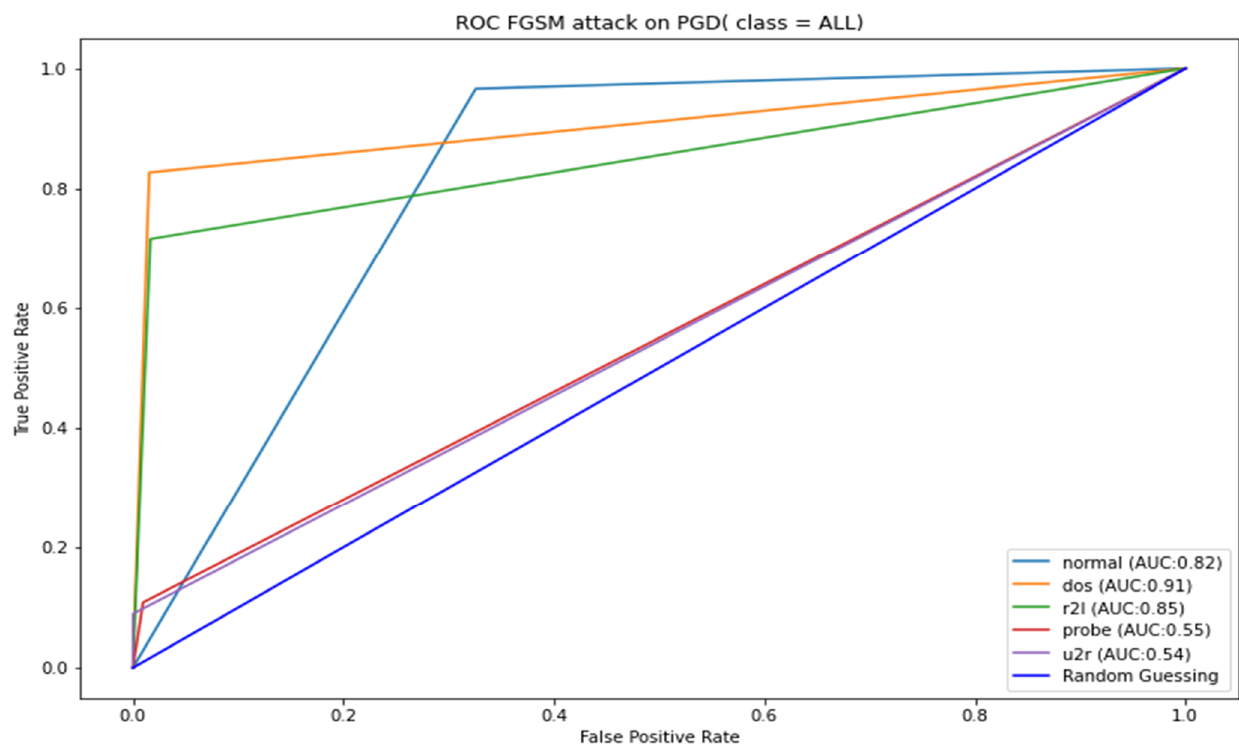
Figure A5. PGD robustness test against FGSM attacks.